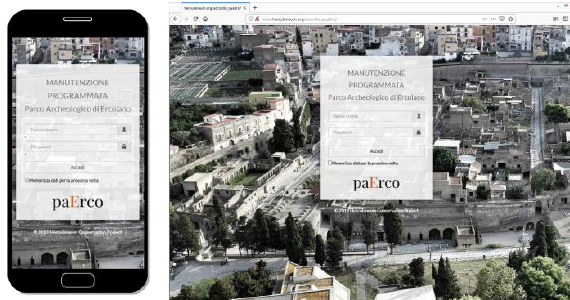
Figure 5: Login page of the web-application built to manage alphanumeric data connected to GIS